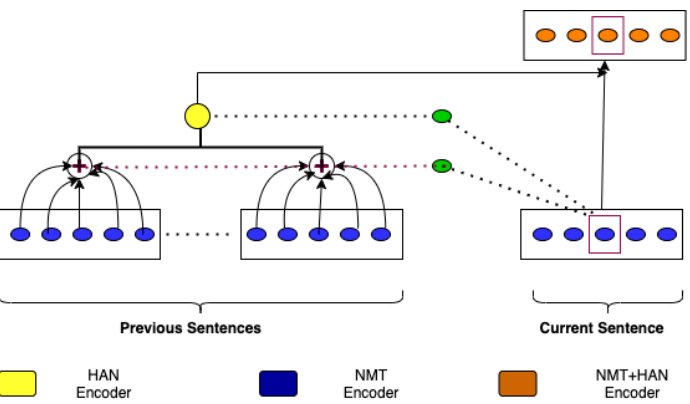
Figure 2. Illustration of the HAN architecture based on Figure 1 in